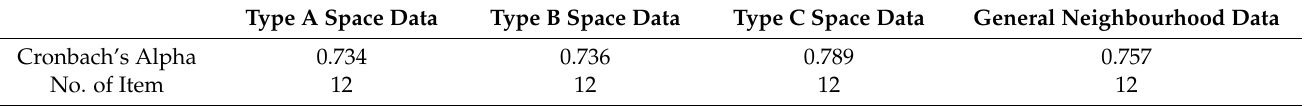
Table 7. Reliability test results of the research instrument based on datasets.